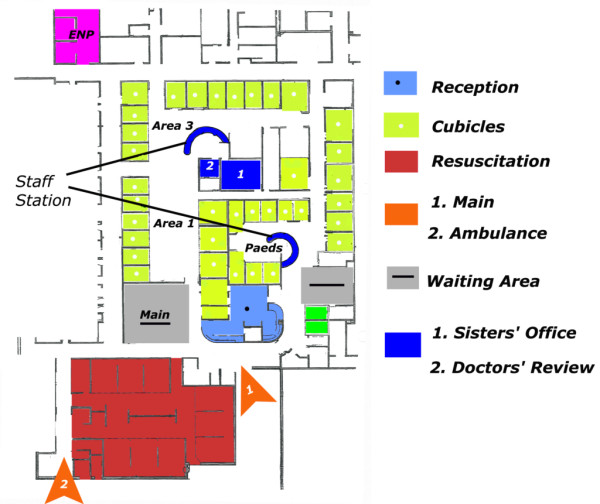
New layout of ED.